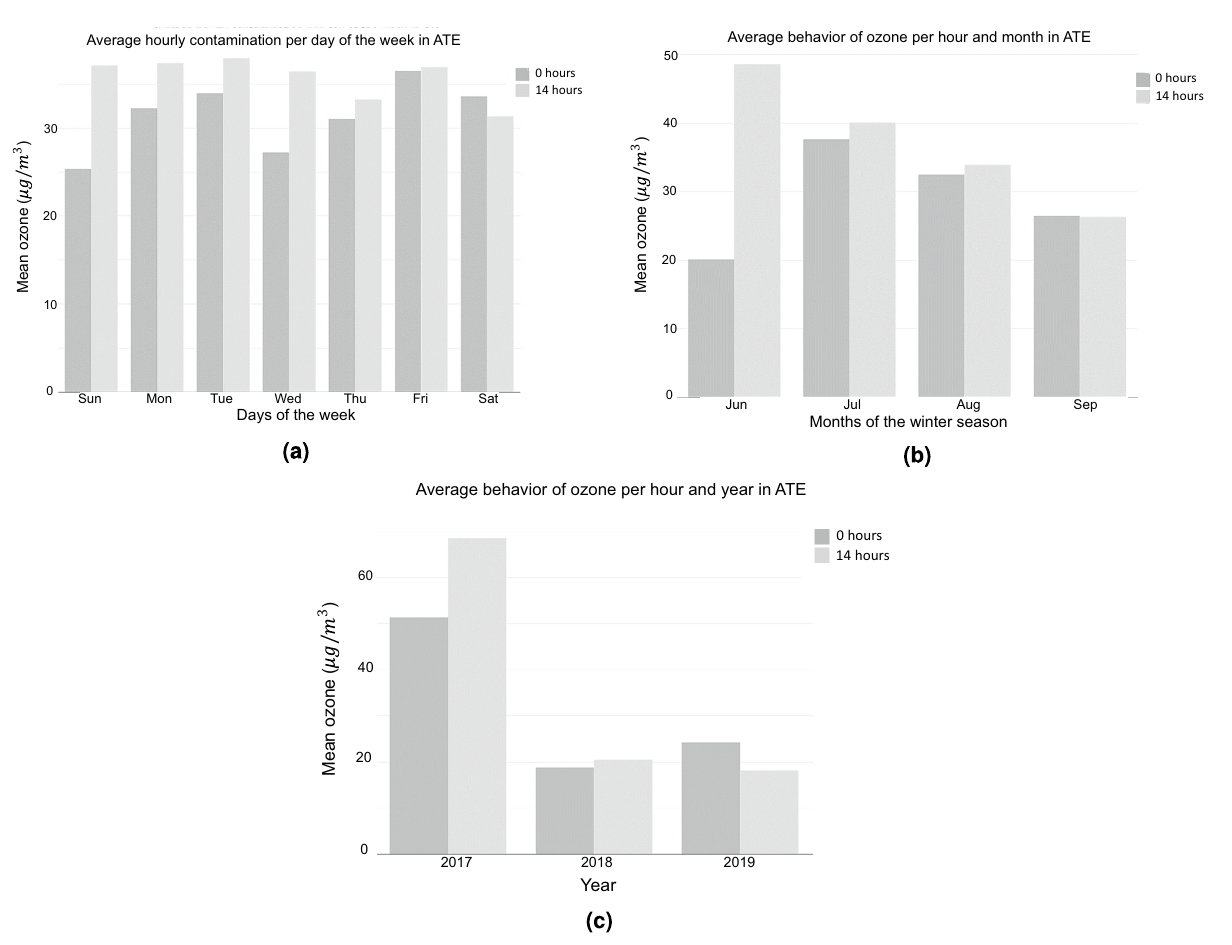
Figure 6. Exploratory analysis per (a) days of the week, (b) months of the winter season and (c) year considering peak hours of contamination in